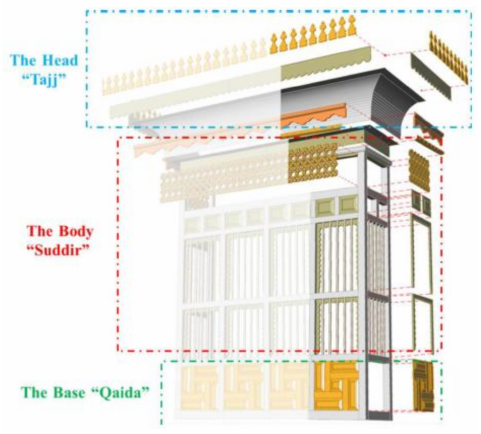
Figure 3. Main parts of a mashrabiya in Jeddah. Reproduced from Alitany et al.